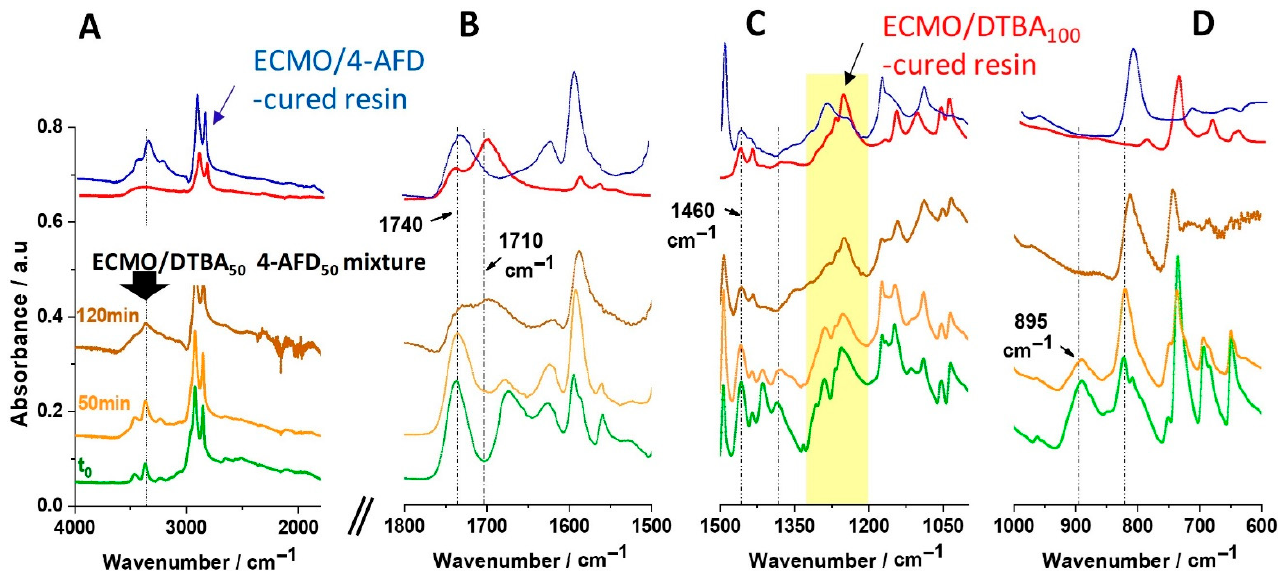
Figure 4. Evolution FT-IR spectra of the ECMO/DTBA 50 4-AFD 50 mixture during curing at 130 °C for different curing times (t = 0, 50, 90, 120 min) in comparison with cured resin of ECMO/DTBA 100 and ECMO/4-AFD 100 : ( A ) zoomed in view of the region from 4000-1800 cm − 1 ; ( B ) zoomed in view of the region from 1800–1500 cm − 1 ; ( C ) zoomed in view from 1500 to 1000 cm − 1 and ( D ) zoomed in view from 1000 to 600 cm − 1 .